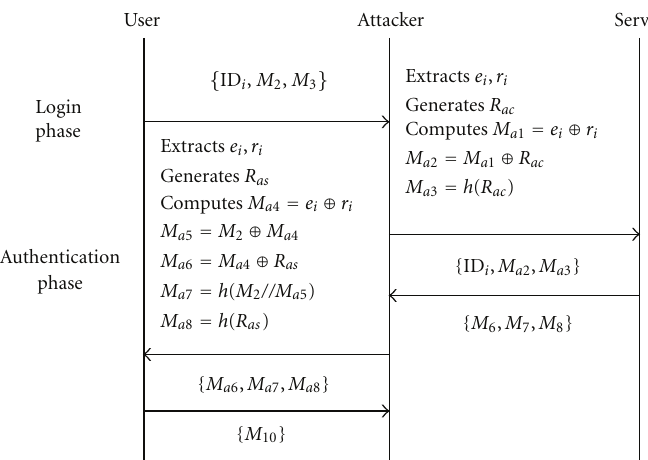
Figure 1: User impersonation attack and server masquerading